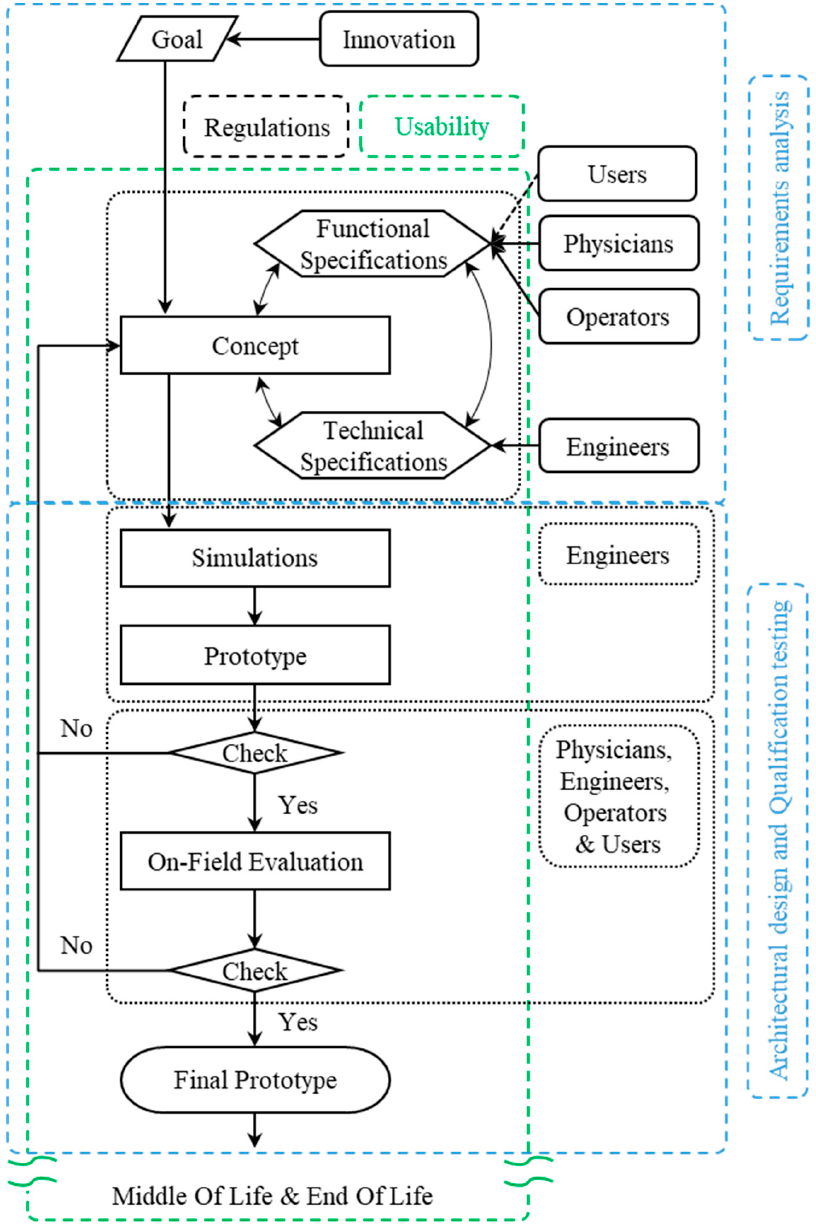
Figure 4. Correspondences between the Usability-Oriented Model for the Design of Medical Devices and the development process defined by the ISO ISO/TR 16982:2002 standard.